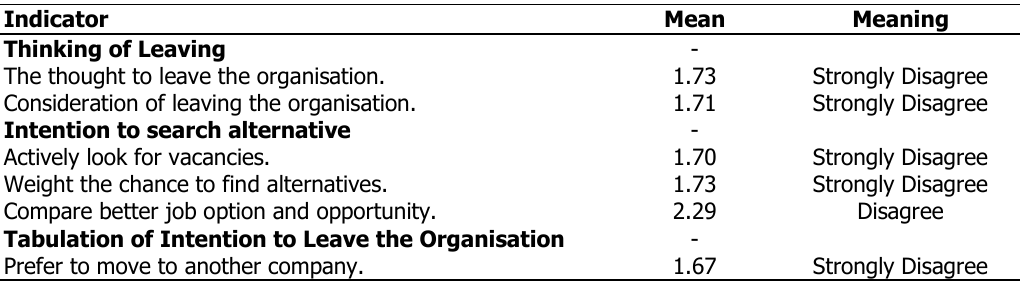
Table 6. Indicator of Other Turnover Intention